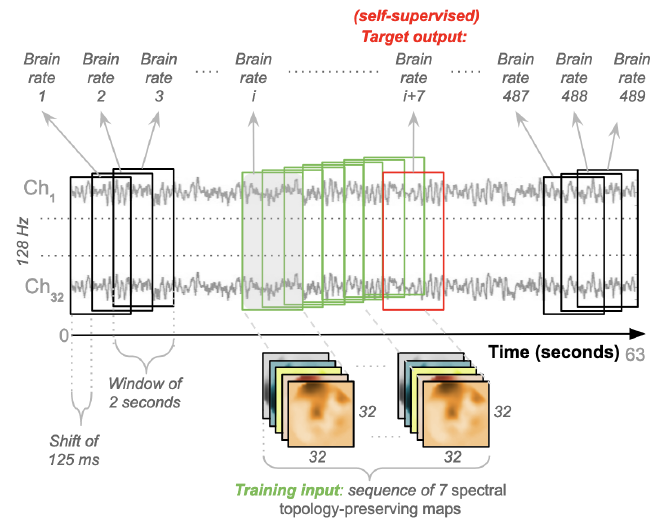
Figure 5. Pipeline for generating sequences for the convolutional-recurrent neural network.